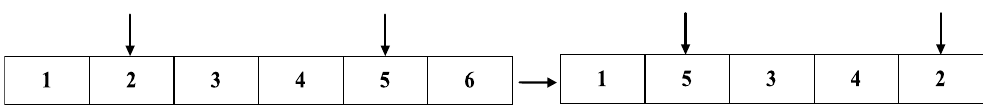
Figure 6. Exchange mutation operator.